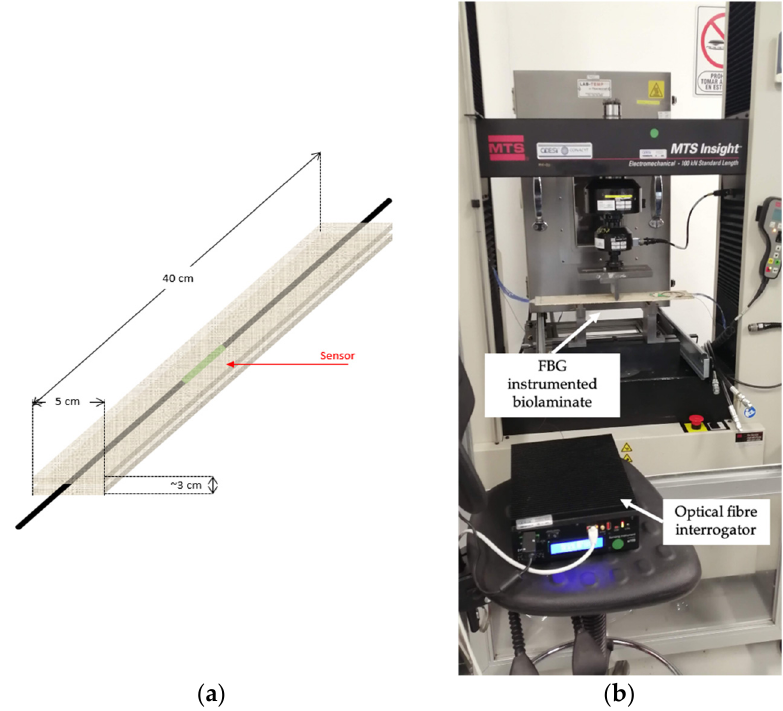
Figure 3. ( a ) FBG biolaminate coupon, ( b ) three-point bending test configuration.